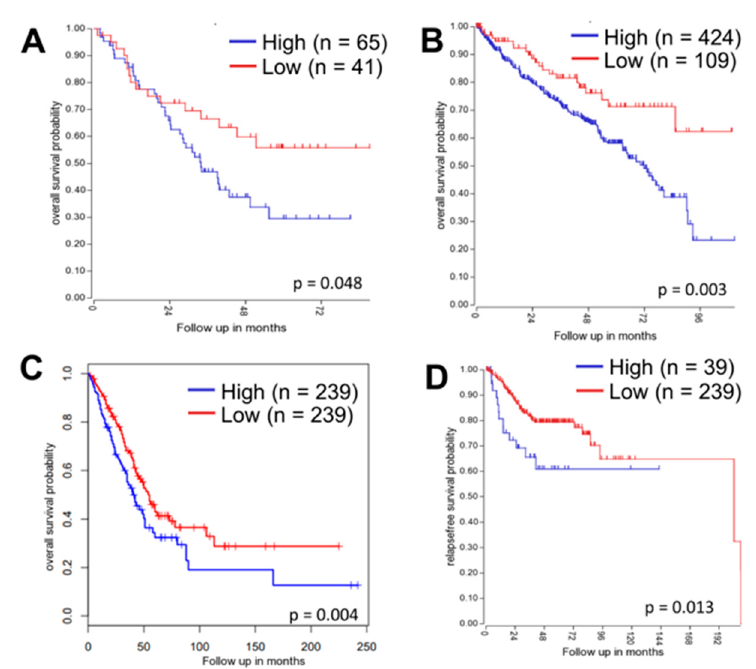
Figure 7. ATG16L1 is a prognostic biomarker of survival and progression in carcinoma patients. ( A ) Low ATG16L1 expression is prognostic for improved overall survival in lung adenocarcinoma patients. ( B ) Low ATG16L1 expression significantly predicts improved overall survival in kidney renal clear cell carcinoma patients. ( C ) Lower ATG16L1 expression in lung adenocarcinoma from The Cancer Genome Atlas dataset is prognostic for improved overall survival; data analyzed using GEPIA—http://gepia.cancer-pku.cn/. ( D ) Low ATG16L1 expression trends with better relapse-free survival in colorectal carcinoma